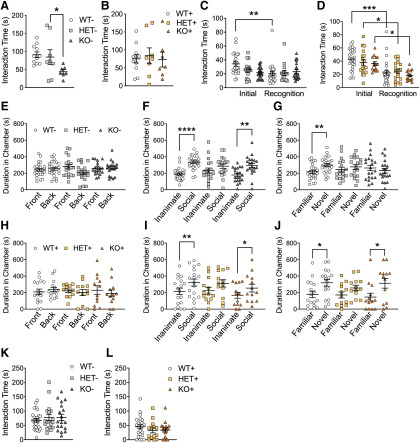
Rescue of social interaction deficits in Shank3+ mutant mice. In the genotype/sex-matched social interaction test, Shank3 KO– mice displayed a significant reduction in social interaction time (A) compared with HET– mice. Shank3+ mice, including both genetic reversal transgenes, all displayed similar durations of social interaction (B) in the genotype/sex-matched social interaction test. In the social interaction with juvenile test of social memory, both HET and KO mice display deficits in social recognition (C). In the genetically reversed Shank3+ mice, however, all genotypes displayed similar levels of social memory (D). In the three-chamber test of sociability, Shank3– mice did not display a chamber preference in the initial trial (E). In second trial of this task, Shank3 HET– mice did not display a preference for the social target over the inanimate object (F). In the third trial of this task, neither Shank3 HET– nor KO– mice displayed a preference for social novelty (G). Shank3+ mice also did not display a baseline chamber preference in the initial trial of the three-chamber test (H). In the second trial, Shank3 HET+ mice did not display a preference for the social target over the inanimate object (I). In the third trial of this task, Shank3 HET+ mice did not display a preference for social novelty (J). Shank3– mice (K) along with Shank3+ mice (L) both display similar social interaction times, respectively, in approach of a novel, caged social target in the caged conspecific test. Data represented as mean ± SEM; *p < 0.05; **p < 0.01, ***p < 0.001, ****p < 0.0001; genotype sex match test n = 11 WT–, n = 8 HET–, n = 7 KO–; n = 11 WT+, n = 8 HET+, n = 7 KO+; all other behaviors n = 24 WT–, n = 16 HET–, n = 20 KO–, n = 24 WT+, n = 19 HET+, n = 16 KO+.